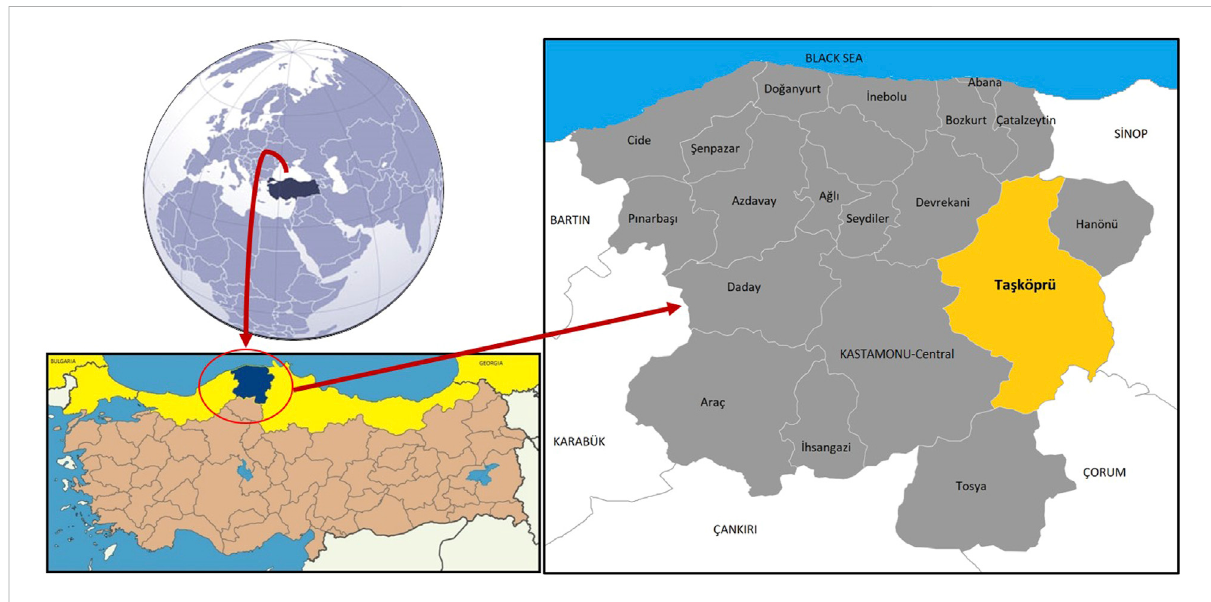
FIGURE 1 Geographical location of Ta ş köprü in